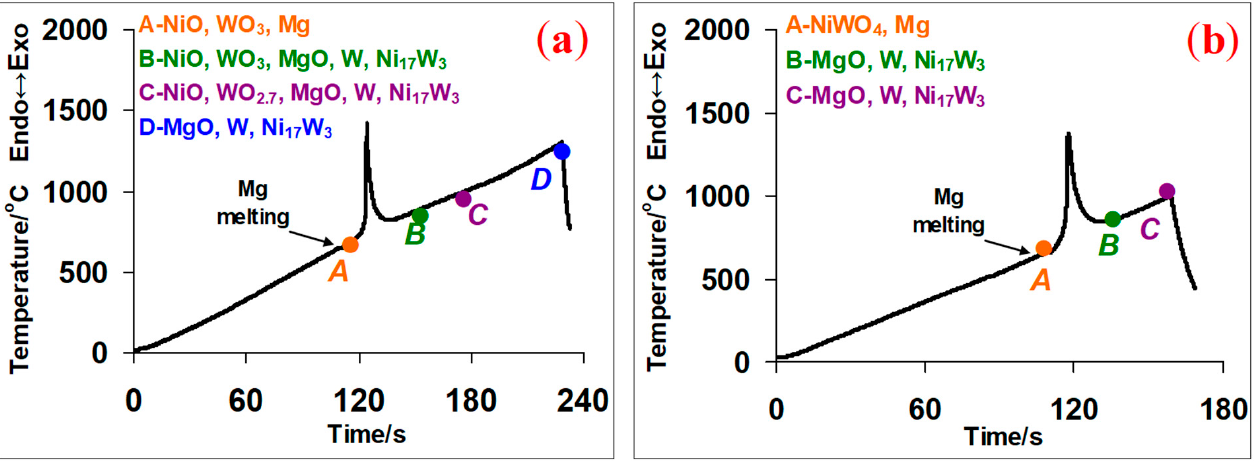
Figure 1. Heating curves of the NiO + WO 3 + 4Mg (( a ) A—700 ◦ C, B—880 ◦ C, C—1000 ◦ C, D—1300 ◦ C) and NiWO 4 + 4Mg (( b ) A—600 ◦ C, B—850 ◦ C, C—1000 ◦ C) mixtures, β = 300 ◦ C min − 1 .